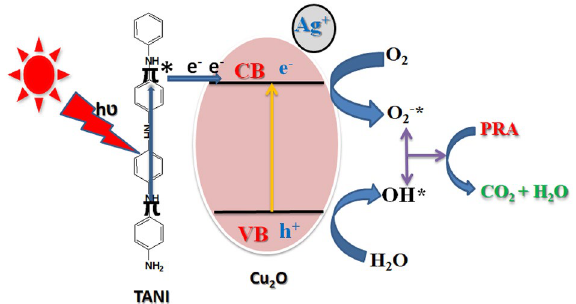
Figure 11. A plausible mechanism for dye degradation by TANI/Cu 2 O/Ag